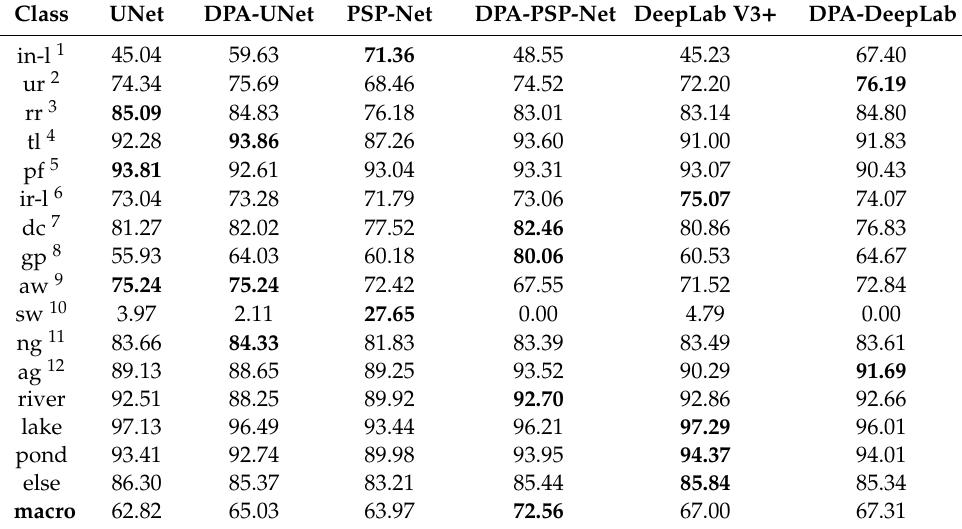
Table 10. F1-score for each category using the di ff erent